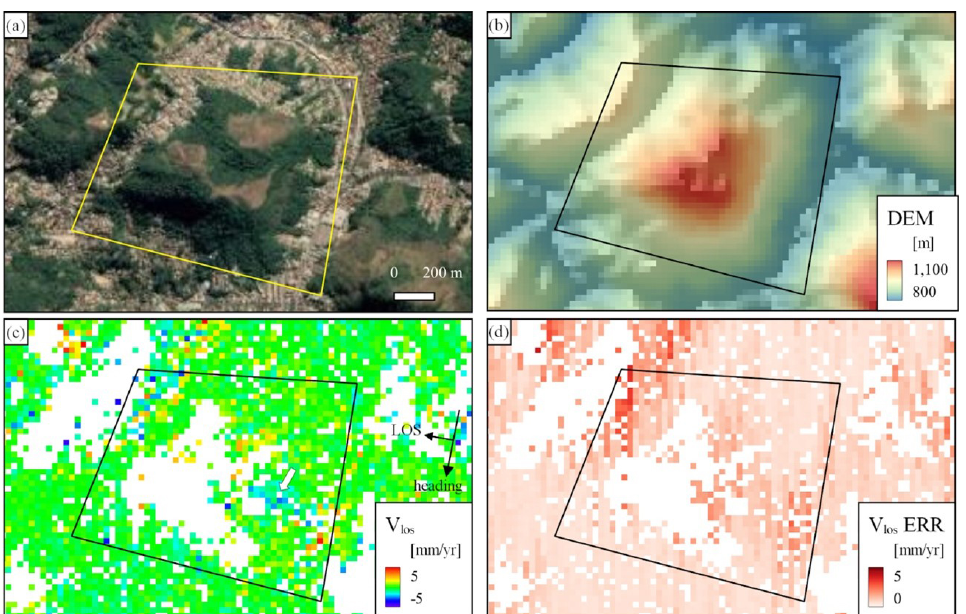
Figure 9. (a) Optical image before February 2022 landslides (image from Google Earth Pro). (b) Digital elevation map (ALOS PALSAR). (c) InSAR line-of-sight (LOS) velocity between 8 May 2015 and 20 December 2021. Note that most areas have nearly zero deformation except for the eastern slope (pointed by a white arrow). (d) Standard deviation of LOS